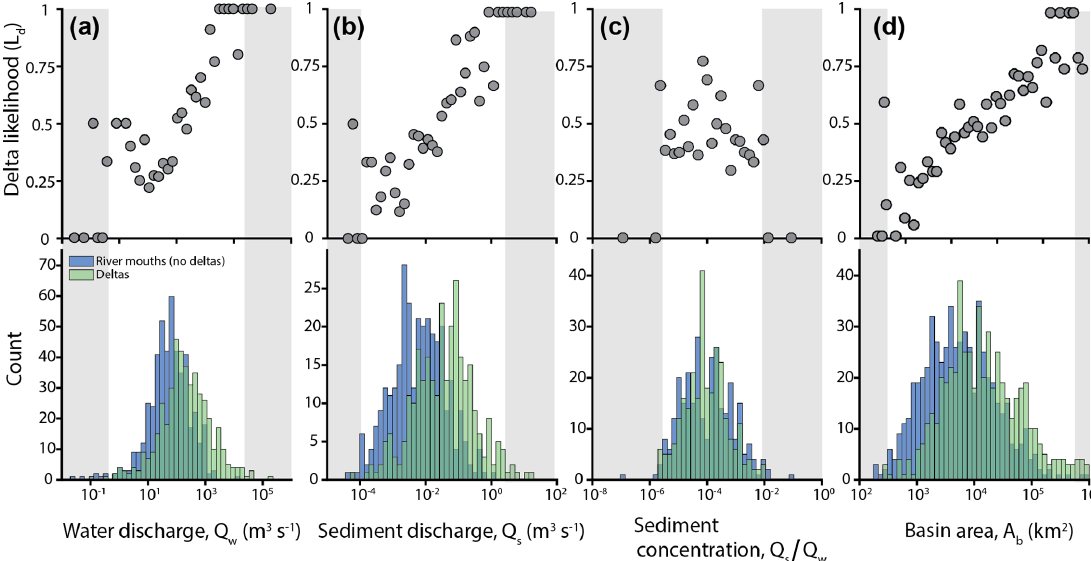
Figure 5. Differences in upstream environmental variables for rivers with and without deltas. Scatter plots (top of each panel) of delta likelihood, defined as the number of rivers with a delta relative to the total number of rivers in that interval. Histograms (bottom of each panel) binned into equal log-spaced intervals. Gray boxes outline ranges represented by 1% or less of the total sample number.